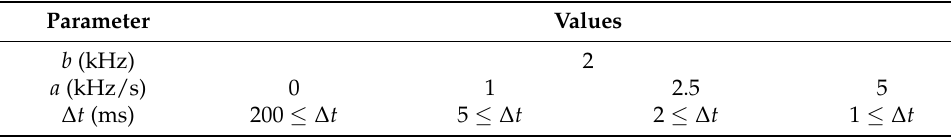
Table 3. Whistle Table 3. Whistle parameters.